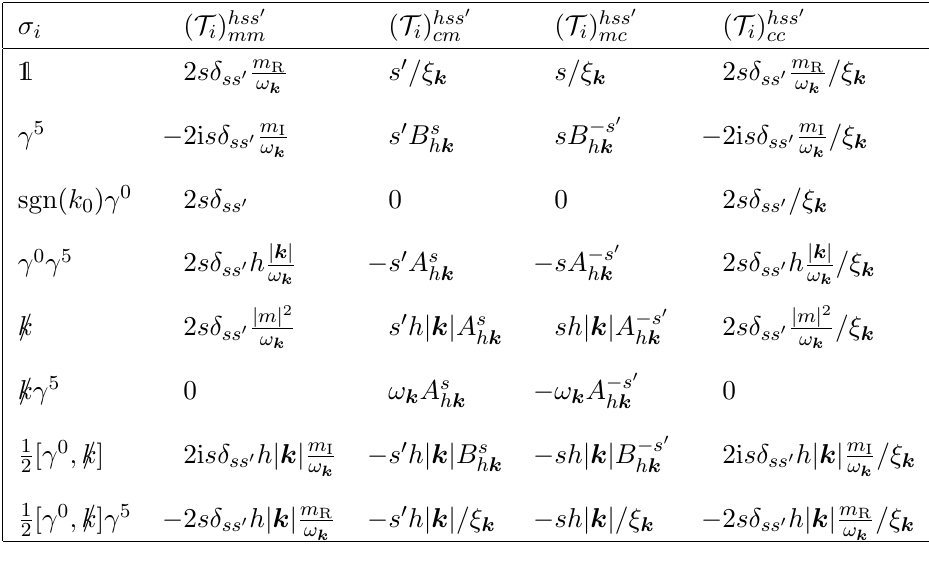
Table 1. Collision term coe(cid:14)cients for di(cid:11)erent self-energy components (cid:27) i ( k ) of (cid:6) k . corresponding to equation (6.2) are given